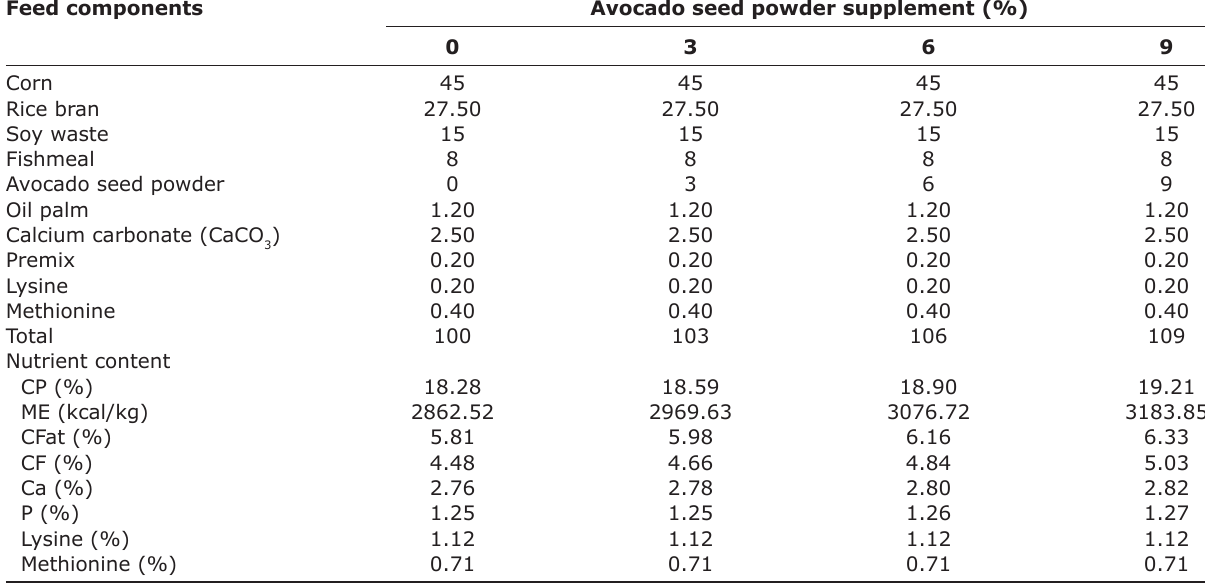
Table-1: Treatment feed formulation. Feed components